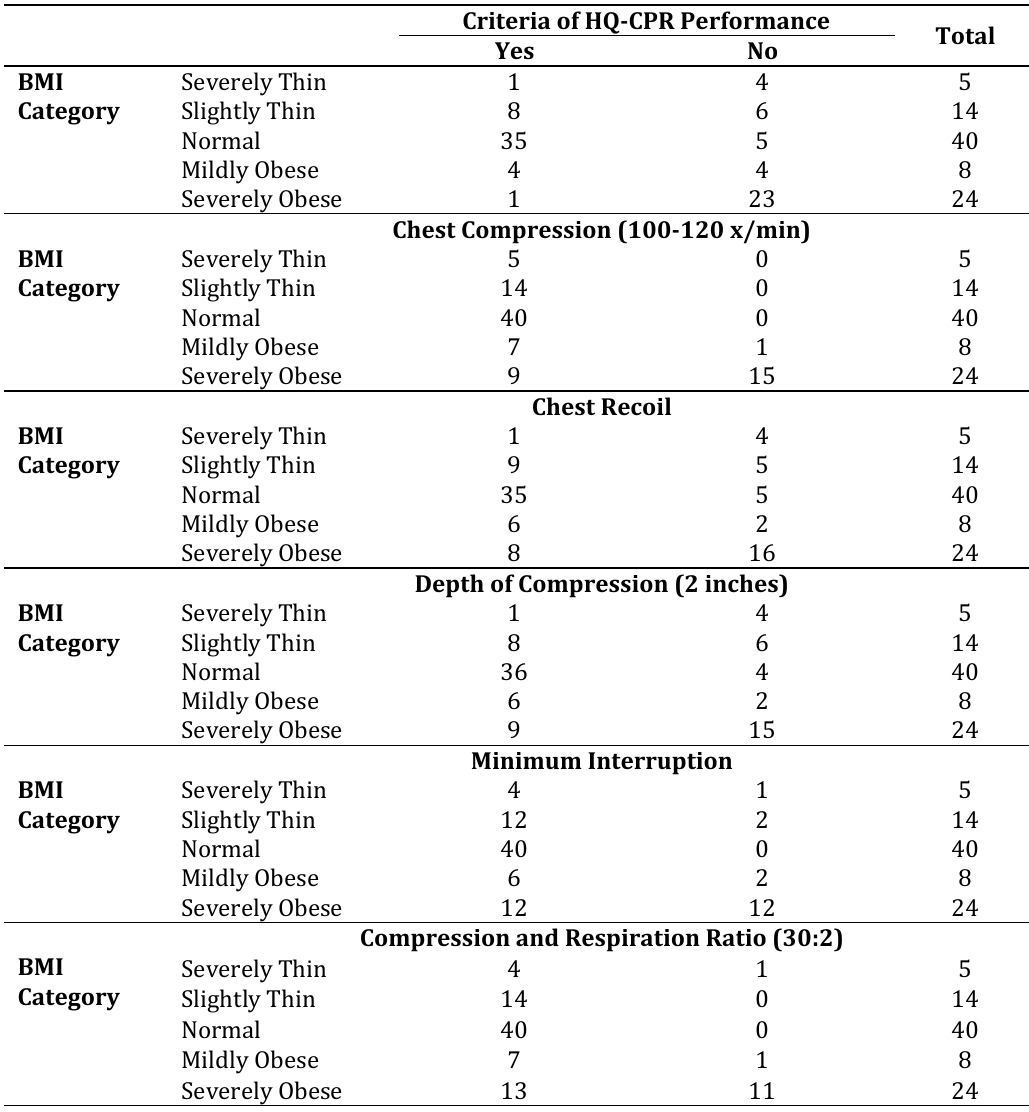
Crosstabulation Analysis of BMI Category and Ability to Perform HQ-CPR